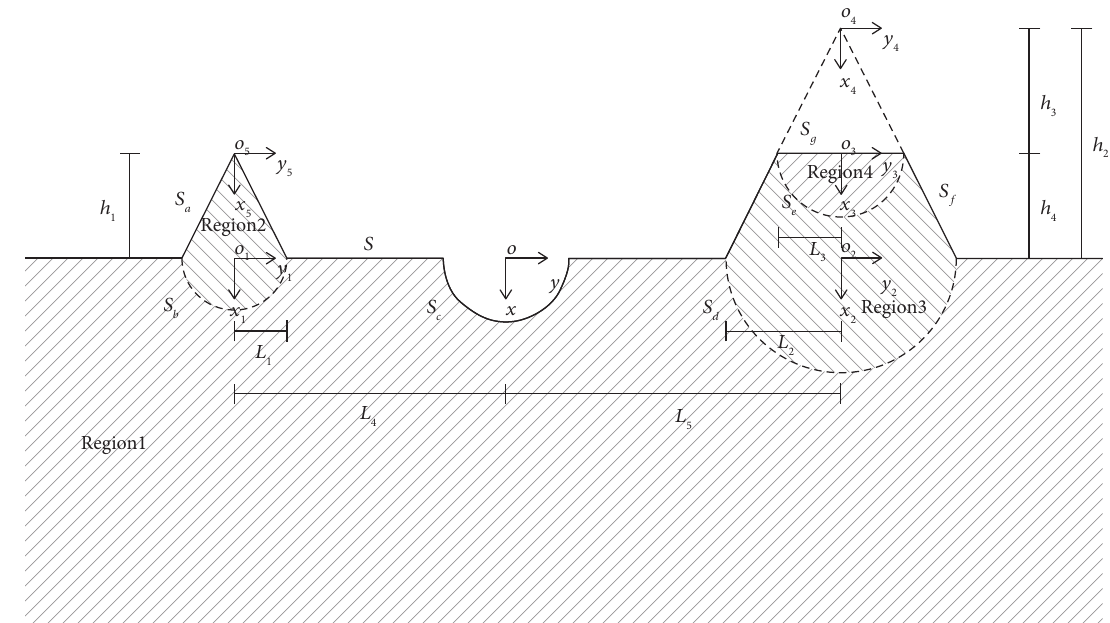
Figure 1: The two-dimensional complex landforms model containing an isosceles triangular hill, semicircle depression, and isosceles trapezoidal hill in half-space.